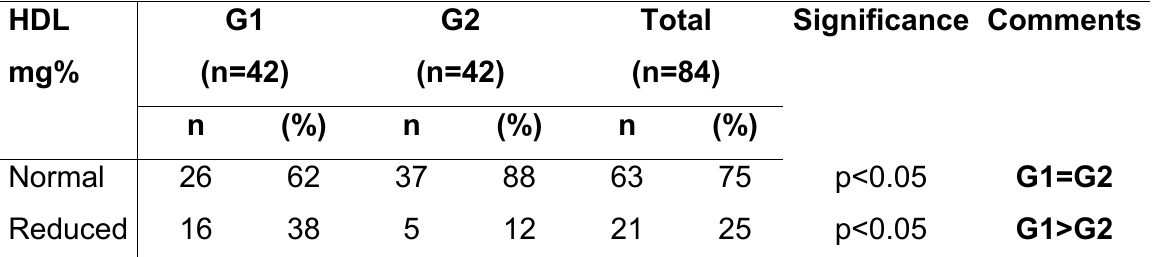
Table 3. Distribution of 84 HIV-1 infected individuals, according to groups, and classification of HDL level into normal or reduced in relation to gender.